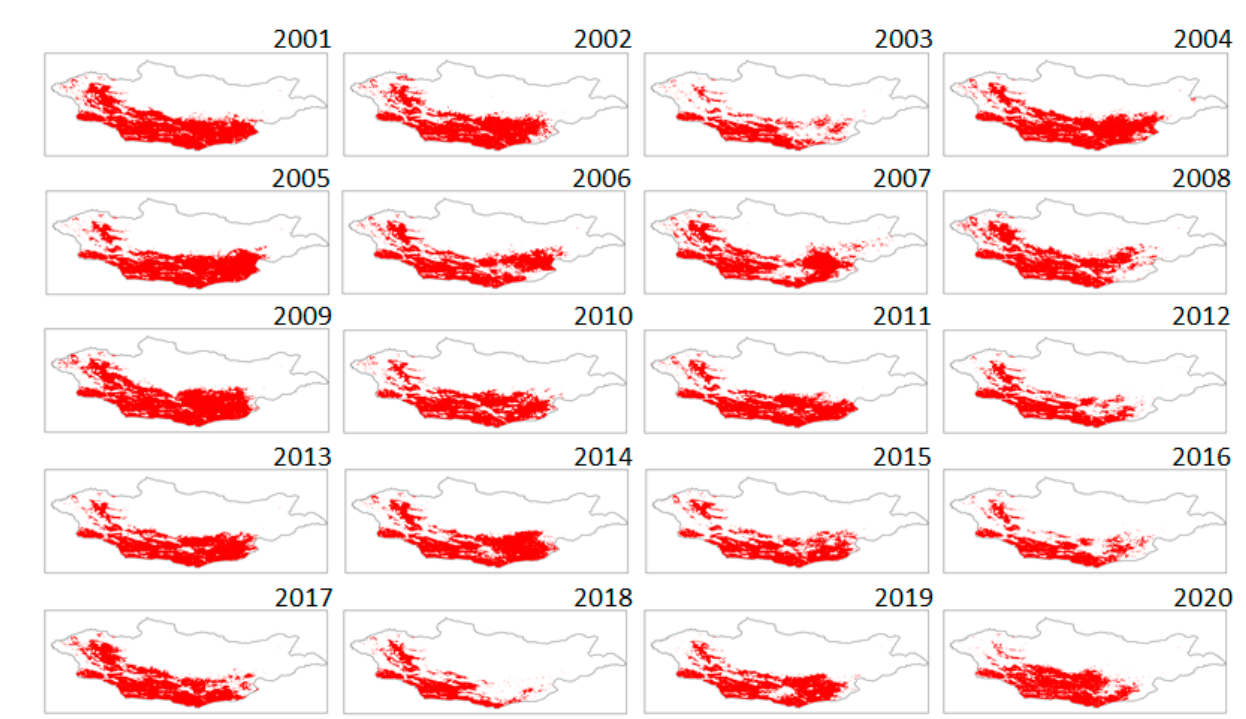
Figure 13. Spatial distribution of degraded land from 2001 to 2020.